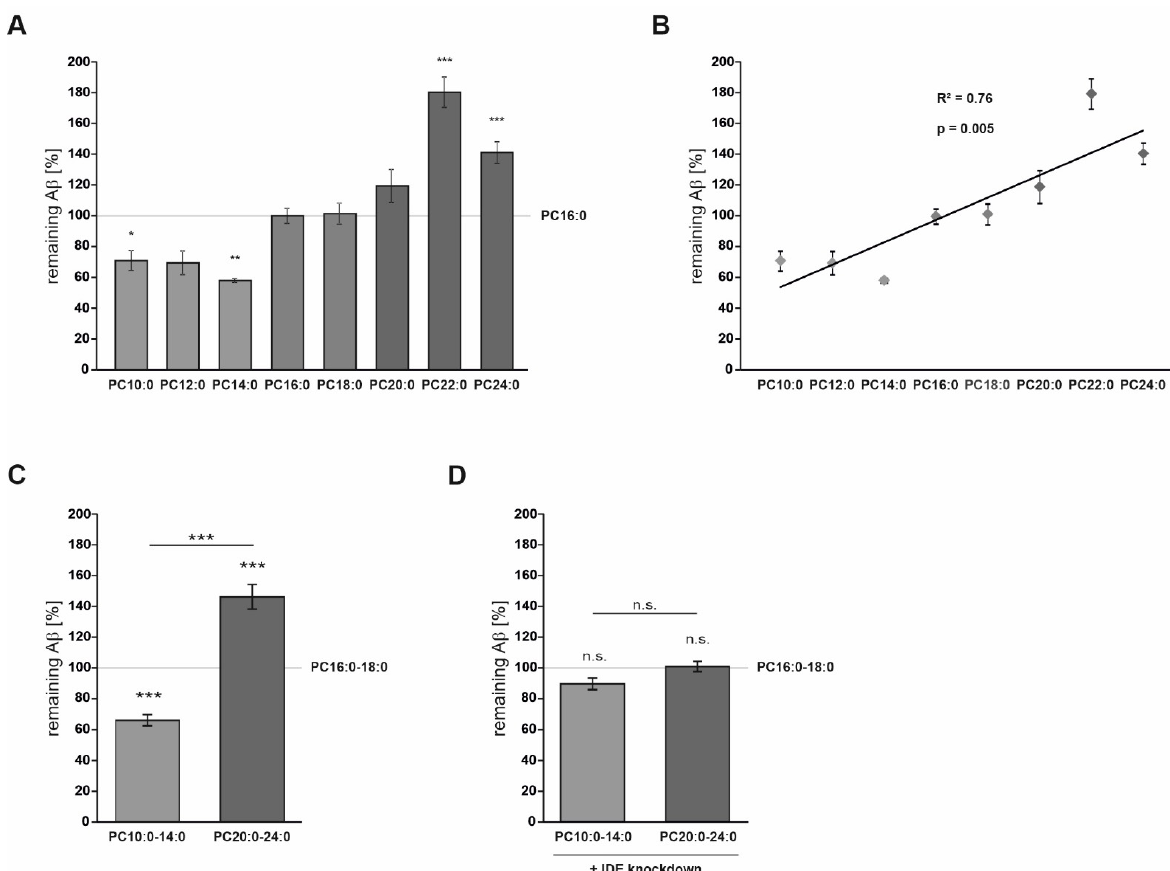
Figure 1. Effect of FA acyl chain length on IDE-dependent A β degradation . ( A ) Analysis of the effect of increasing FA carbon chain length (PC10:0, PC12:0, PC14:0, PC18:0, PC20:0, PC22:0 and PC24:0) on total A β degradation in mouse Neuro2a control cells compared to PC16:0 (set at 100%) ( n ≥ 3). ( B ) Pearson correlation between the FA acyl chain length and the level of remaining human A β 40 peptides (R 2 = 0.76 and R = 0.87). ( C ) Pooled analysis of the effect of the examined phospholipids on A β degradation (PC10:0–14:0 and PC20:0–24:0 compared to PC16:0–18:0 (set at 100%), respectively) by Western Blot ( n > 11). ( D ) Investigation of the effects of FA acyl chain length on total A β degradation in stably transfected Neuro2a IDE-knockdown cells (Neuro2a IDE KD) ( n ≥ 9). Statistical significance was set as * p ≤ 0.05; ** p ≤ 0.01 and *** p ≤ 0.001. n.s.: not significant.